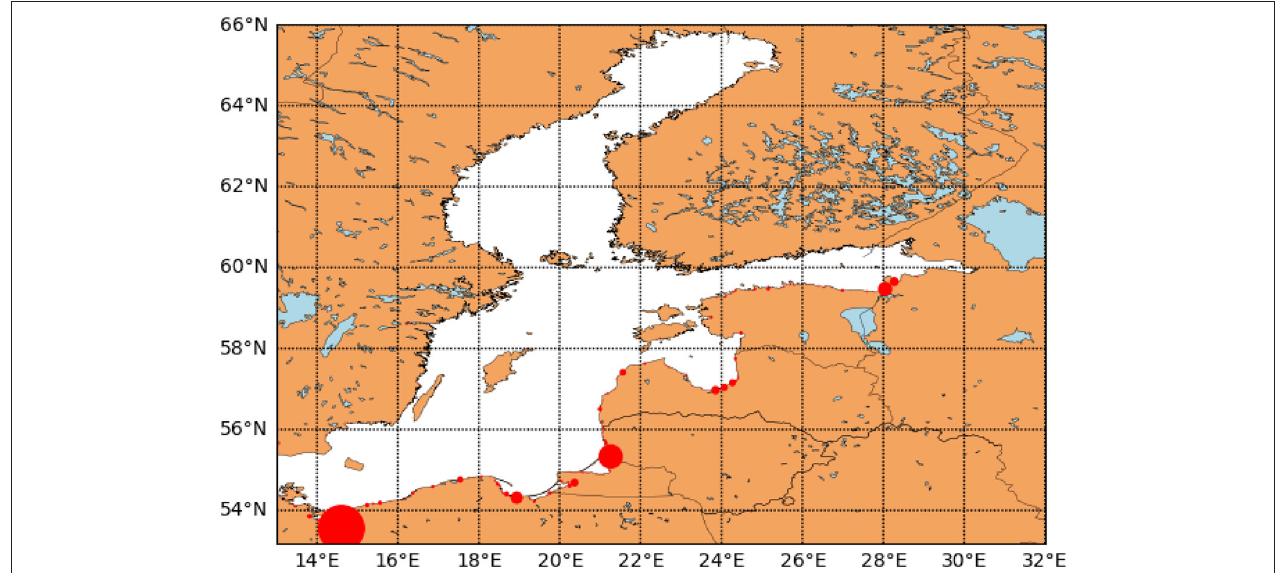
FIGURE 2 | River sources of macroplastic inflow to the Baltic west of 13 ◦ E; circle diameter is scaled according to yearly influx. The largest river source is Oder in the lower left corner corresponding to 67.2 tons/year.